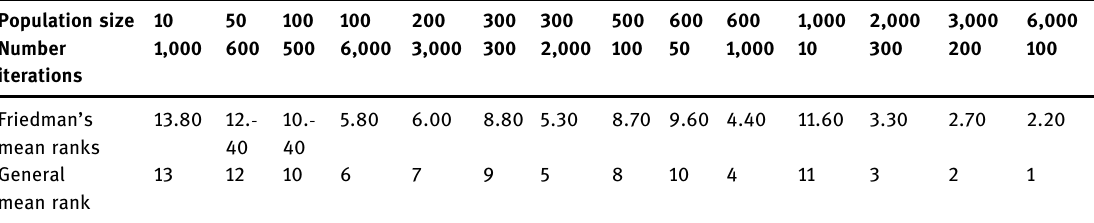
Table 5: Friedman ’ s test mean rank for solution size and number of